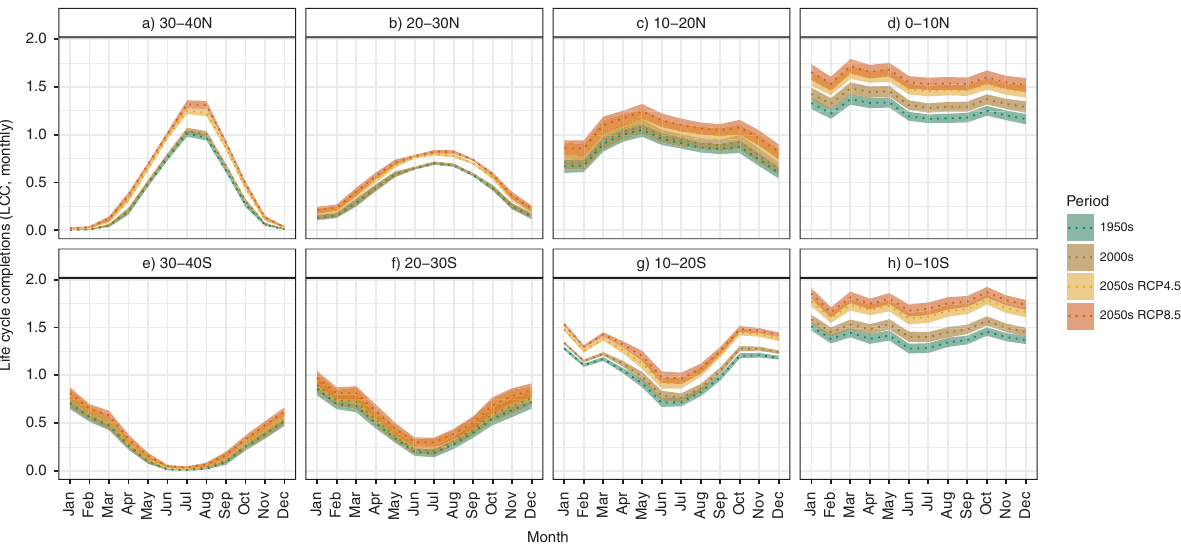
Fig. 5 Seasonal pro fi les of LCC based on monthly averages in latitudinal zones. Monthly average LCC within the latitudinal zones are shown for the years December, and the y axis is monthly average LCC within each latitudinal zone ( a ) – ( h ) (40°S to 40°N). Colours indicate time period and climate change scenario, where dotted lines indicate means and ribbons around the lines represent 95% CIs to illustrate variability attributable to underlying